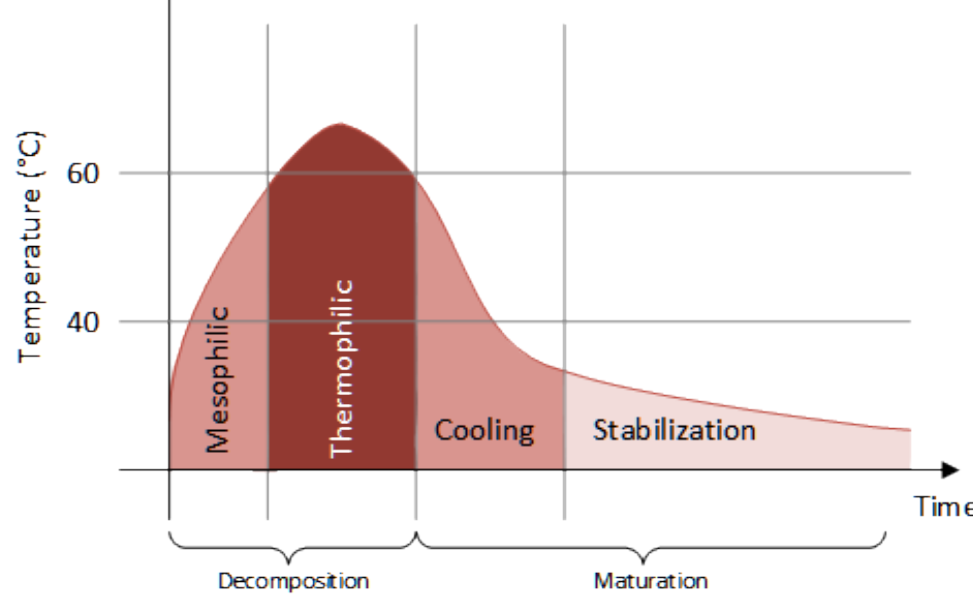
Figure 1. Temperature evolution during the composting